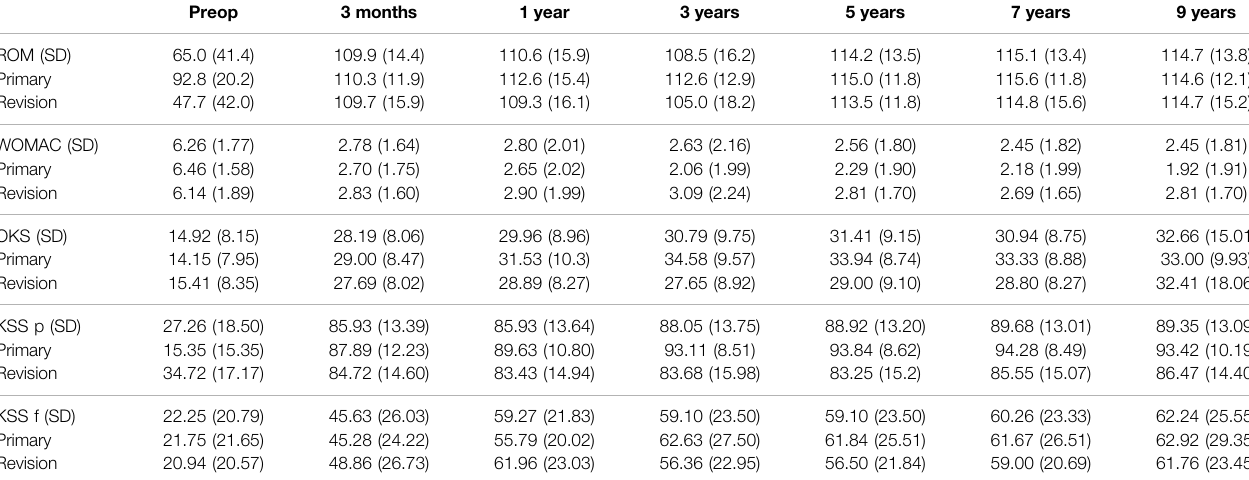
TABLE 2 | Detailed overview on clinical and functional scores from preoperative to 9 years after surgery. Results improved in the fi rst 3 months after surgery and showed signi fi cant differences compared to preoperative values ( p < 0.0001). Values stayed at the same level and did not signi fi cantly change thereafter (SD ... standard deviation).